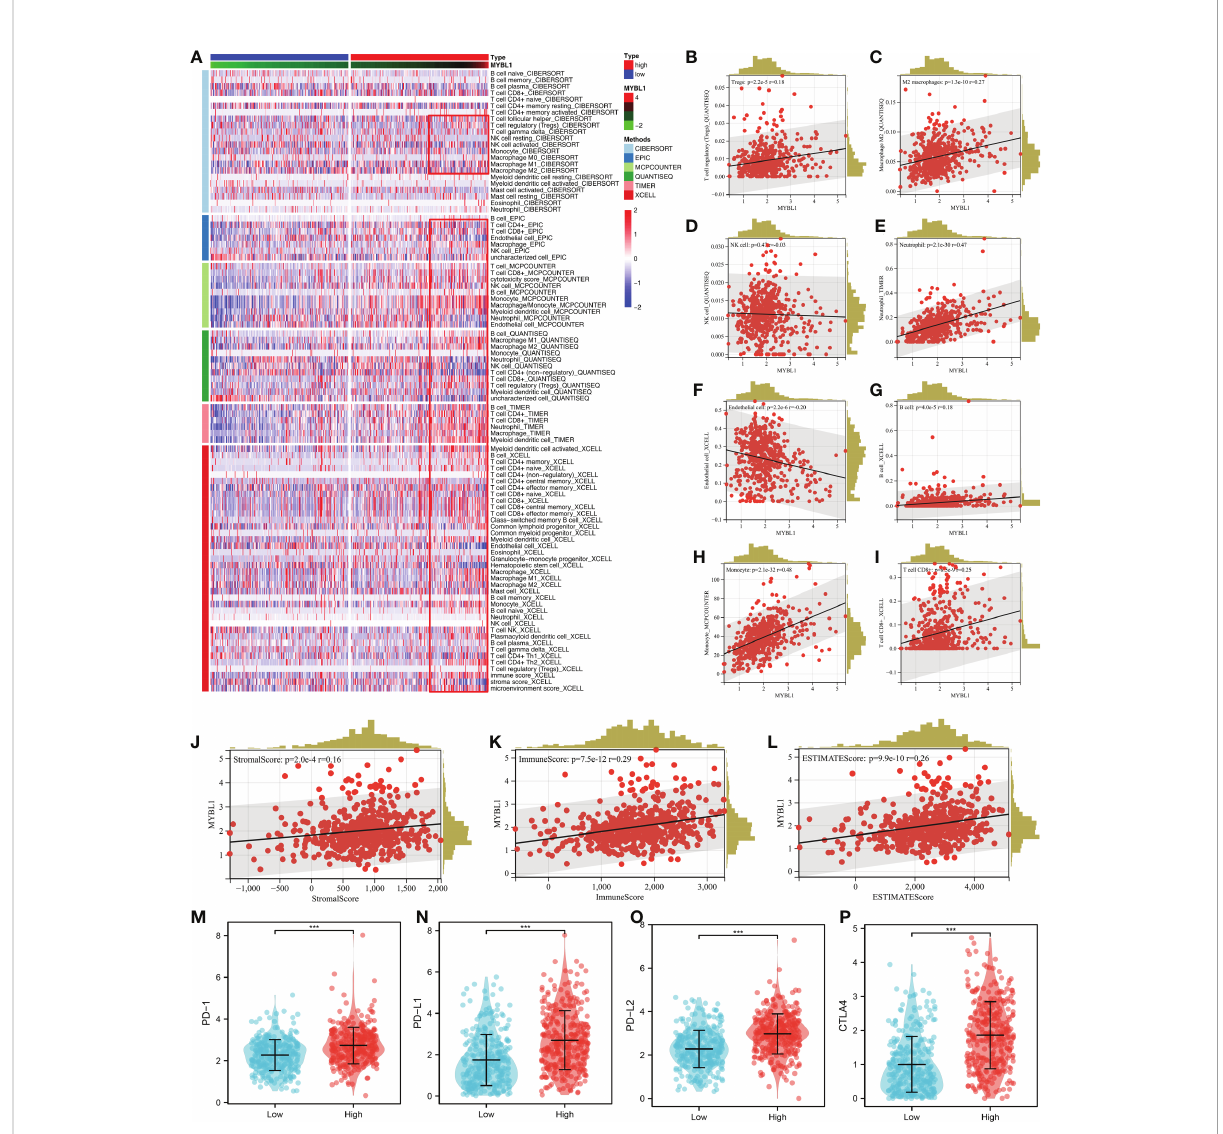
FIGURE 3 The immune landscape of MYBL1. (A) Immune in fi ltration of MYBL1; (B – I) Correlation between MYBL1 and multiple immune cells; (J – L) Correlation of MYBL1 and immune score, stromal score and estimate score; (M – P) The expression level of key immune checkpoints in patients with high and low MYBL1